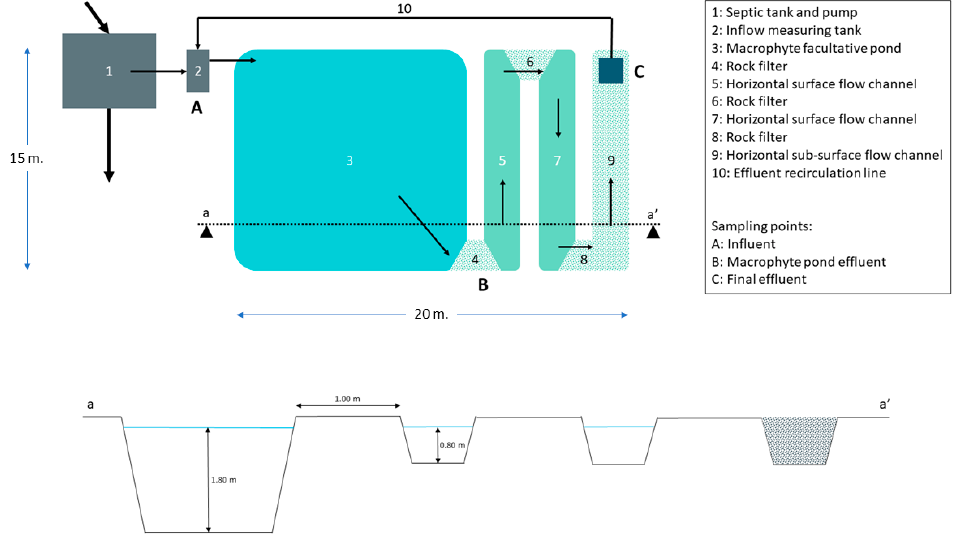
Figure 1. Scheme and vertical section (not to scale) of the studied system.